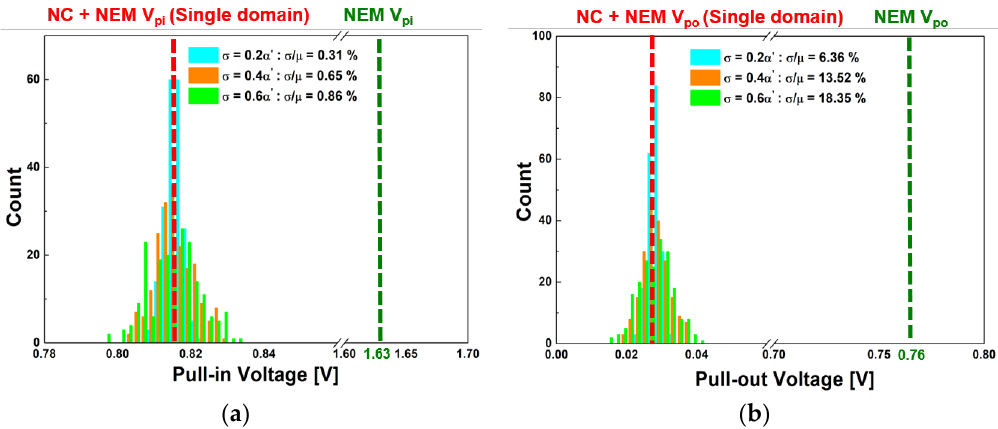
Figure 7. Distribution of ( a ) pull-in voltage and ( b ) pull-out voltage for NEM relay, NEM relay with single-domain ferroelectric and 200 samples of NEM relay with multi-domain ferroelectric. Note that variation in pull-in/-out voltage increases as domain inhomogeneity increases.